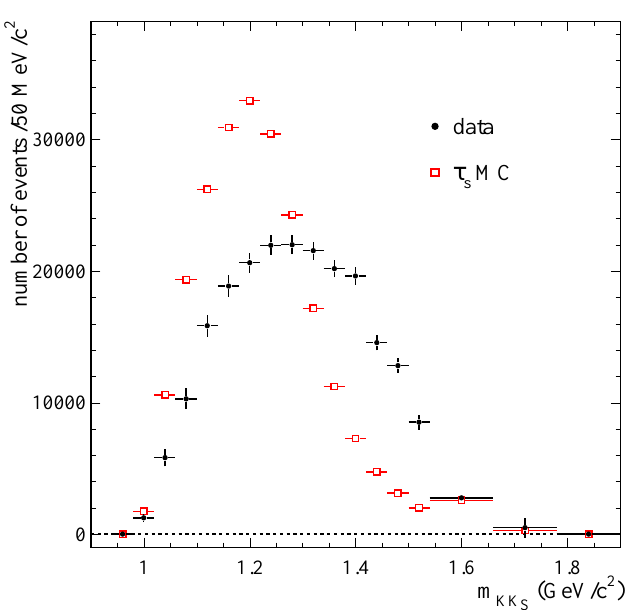
Figure 4: Measured m spectra for signal events in comparison with the Monte K − K S Carlo